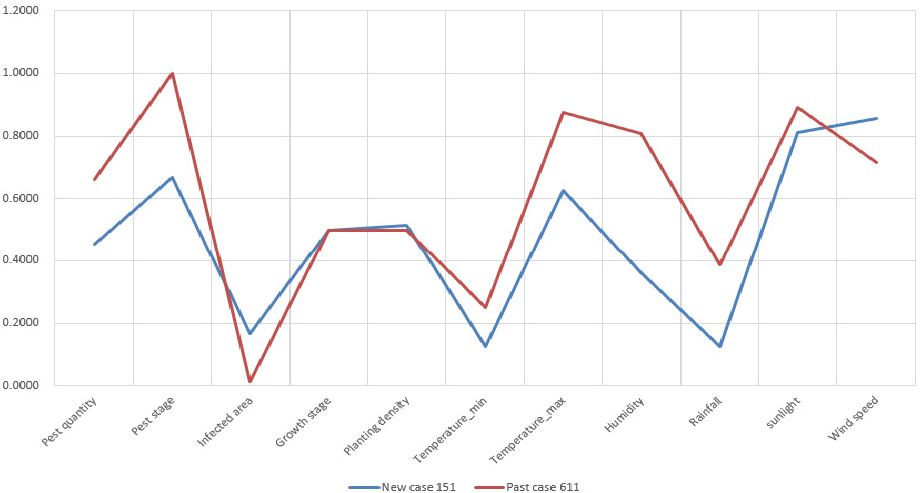
Figure A6. Attribute visualization of new case 151 and retrieved past case